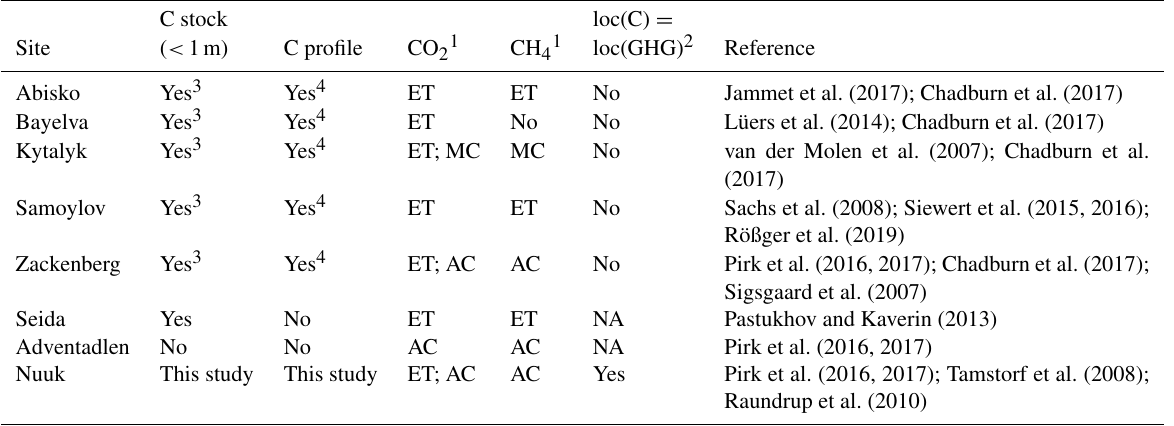
Table 1. Short review of available carbon stocks, profiles, and CO 2 and CH 4 fluxes for different sites. C